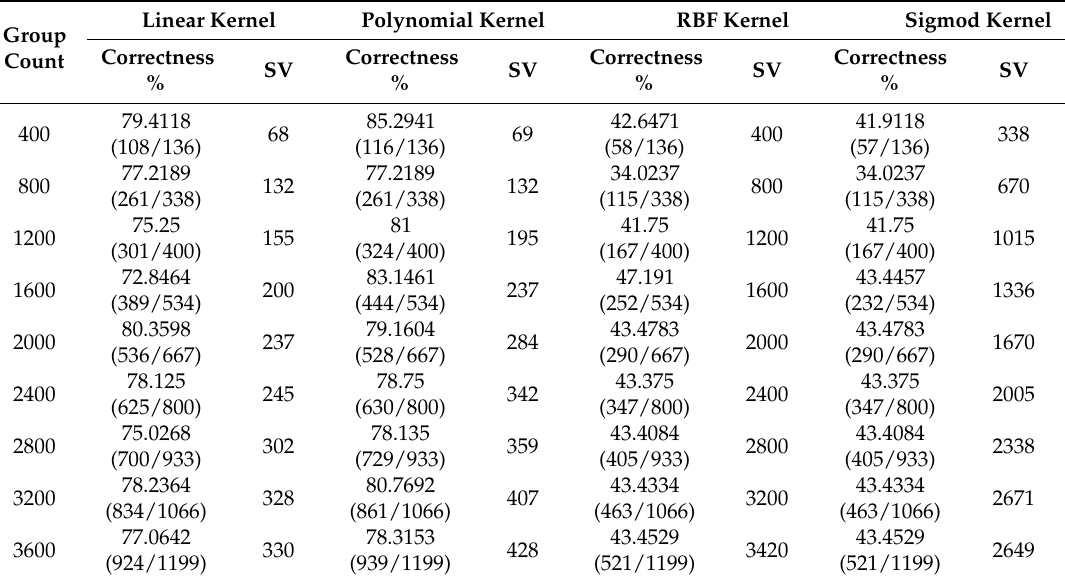
Table 1. Kernel function selection ( c -1, g -0.7).